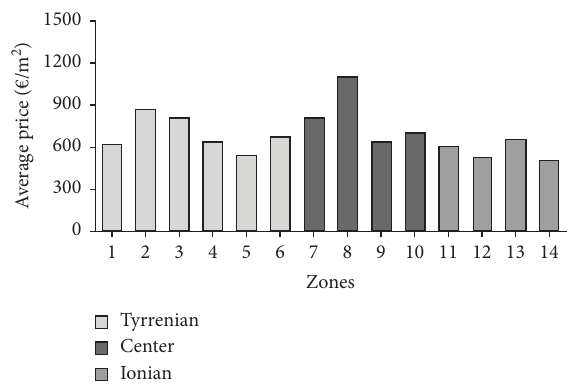
Figure 7: Average selling price per zone of residential